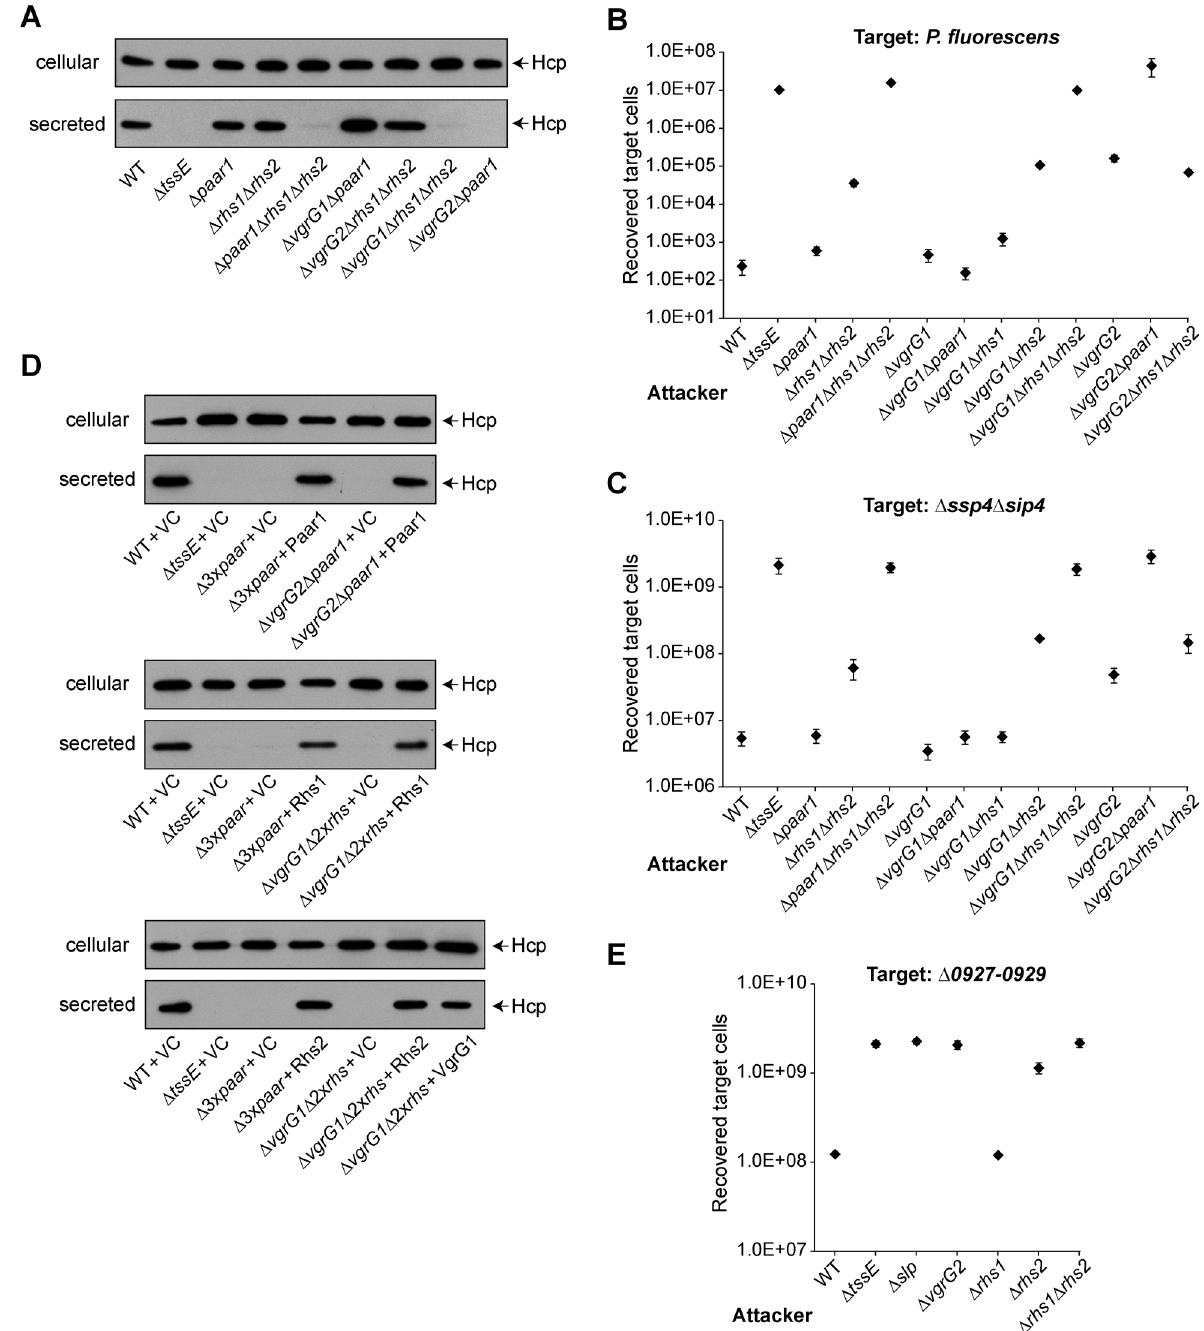
Fig 5. VgrG1 and VgrG2 require specific PAAR proteins to assemble a functional T6SS. (A) Immunoblot detection of Hcp1 in cellular and secreted fractions of wild type (WT) or mutant ( Δ tssE , Δ paar1 , Δ rhs1 Δ rhs2 , Δ paar Δ rhs1 Δ rhs2 , Δ vgrG1 Δ paar1 , Δ vgrG2 Δ rhs1 Δ rhs2 , Δ vgrG1 Δ rhs1 Δ rhs2 and Δ vgrG2 Δ paar1 ) strains of S . marcescens Db10. (B-C) Recovery of target organisms P . fluorescens 55, part B, or S . marcescens Db10 Δ ssp4 Δ sip4 , part C, following co-culture with wild type or mutant strains of Db10 as attacker (mutants as part A, with also Δ vgrG1 , Δ vgrG2 , Δ vgrG1 Δ rhs1 and Δ vgrG1 Δ rhs2 ). Points show mean +/- SEM (n = 4). (D) Hcp1 secretion by wild type or mutant strains carrying either the vector control plasmid (+VC) or plasmids directing expression of Paar1 (+Paar1, pSC734), Rhs1 and RhsI1 (+Rhs1, pSC791), Rhs2 and RhsI2 (+Rhs2, pSC788), or VgrG1 (+VgrG1, pSC622) in trans . The empty vector control was pSUPROM for Paar1, Rhs2 and VgrG1; for Rhs1 the empty vector was pBAD18-Kn and expression was induced with 0.0002% L -arabinose. Abbreviations: Δ 3x paar , Δ paar Δ rhs1 Δ rhs2 ; Δ 2x rhs , Δ rhs1 Δ rhs2 mutant (E) Recovery of target strain S . marcescens Db10 Δ 0927 – 0929 following co-culture with wild type (WT) or mutant ( Δ tssE , Δ slp , Δ vgrG2 , Δ rhs1 , Δ rhs2 and Δ rhs1 Δ rhs2 ) strains of Db10.